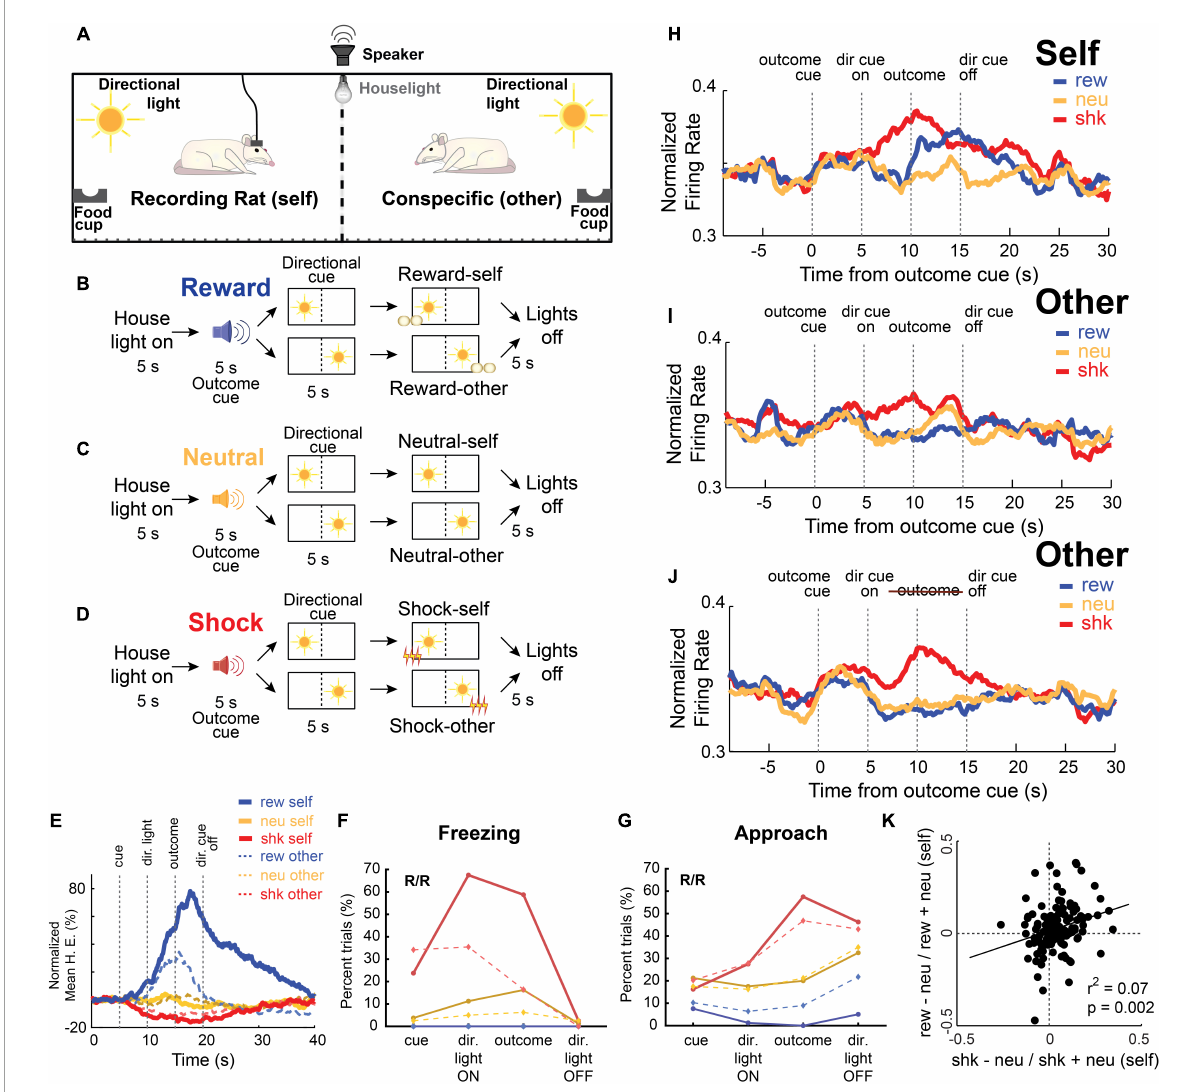
FIGURE2 (A–D) Pavlovian social outcome task that interspersed reward (B) , neutral (C) , and shock (D) trials. Pairs of rats (recording rat and conspecific) were placed in a chamber, separated by a divider that allowed them to hear, smell, and see each other. Each trial begins with the onset of a house light; after 5 s, an auditory cue indicates the type of outcome that will be delivered (shock, reward, or none), and a 10 s directional light cue indicates which side the outcome will be delivered to (recording rat or conspecific). (E) Average beam breaks (food cup entry) as a percentage of trial time for each type of outcome (blue: reward; yellow: neutral; red: shock) for outcomes delivered to self (solid lines) and the conspecific (dashed lines). (F) Percentage of trials recording rats froze during each epoch for each type of outcome (blue: reward; yellow: neutral; red: shock) for outcomes delivered to self (solid lines) and the conspecific (dashed lines). (G) Same as panel (F) , but for rat approach to the divider – defined as when the recording rat moved toward, or was actively interacting at, the divider. (H–J) Normalized average firing rate of all recorded ACC neurons ( n = 139) across each trial type (blue: reward, red: shock, yellow: neutral) for outcomes delivered to self (H) and the conspecific (I,J) . In panel (J) , predictive cues were used but no outcomes were delivered to the conspecific. (K) Correlation of ACC activity on shock-self and reward-self trials. Adapted from Schneider et al.